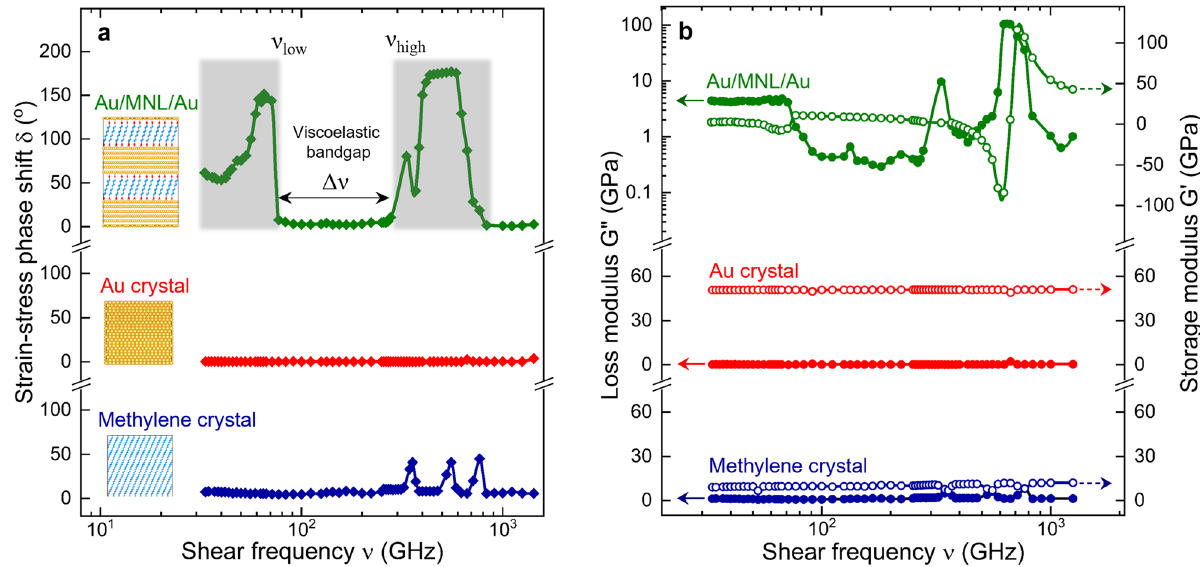
Figure 1. Viscoelastic bandgap in Au/octanedithiol MNL/Au multilayers. ( a ) Strain–stress phase shift in Au/ octanedithiol MNL/Au multilayers, and the reference bulk crystals of Au and methylene chains as a function of frequency. The viscoelastic bandgap is given by Δν = ν high − ν low where ν high and ν low represent band edges. ( b ) Frequency-dependence of loss and storage moduli, G’’ and G’,